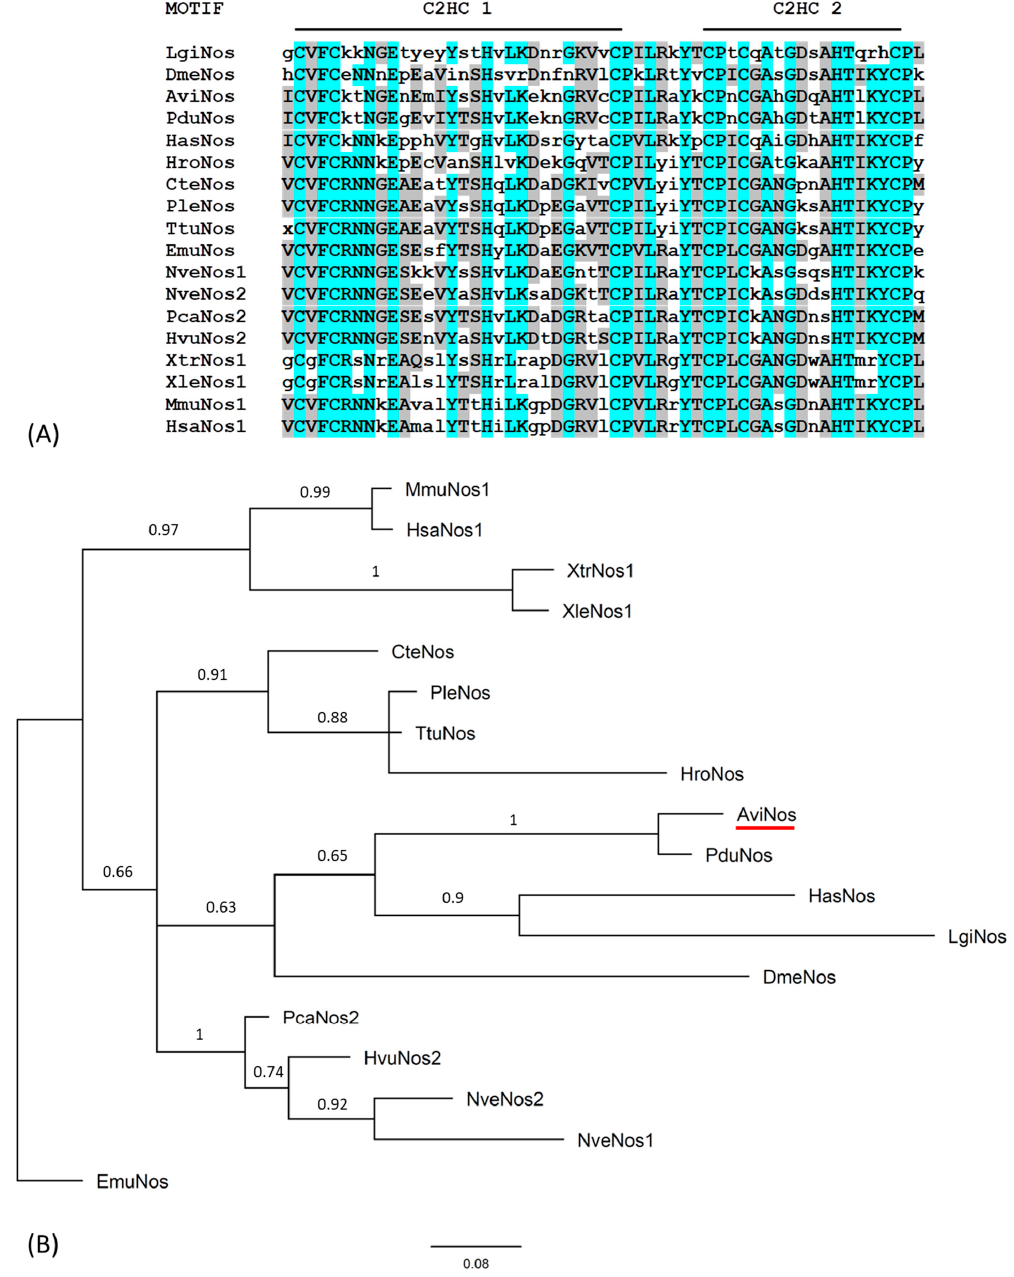
Figure 1. Sequence alignment and phylogenetic analysis of nanos gene from Alitta virens . ( A ) Mul- tiple sequence alignment of AviNos ( underlined in red ) with other Nanos zinc finger domain se- quences from vertebrates and invertebrates. ( B ) Phylogenetic analysis of Alitta virens nanos gene. Bayesian consensus tree of the CCHC zinc finger domain of metazoan nanos genes: AviNos ( Alitta virens , GenBank OL456152); CteNos ( Capitella teleta , DAA06318.1); DmeNos ( Drosophila melanogaster